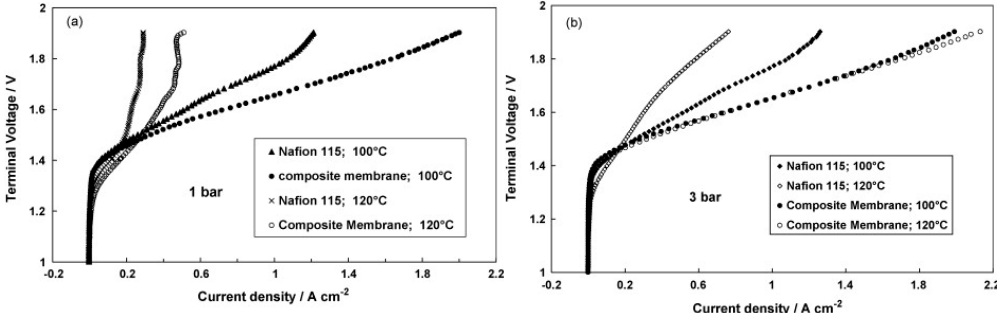
Figure 10. Comparison of voltage and current density of Nafion 115 and composite Nafion-SiO 2 membrane at 100 and 120 ◦ C and at 1 bar abs ( a ) and 3 bar abs ( b ); reproduced with permission from [213].